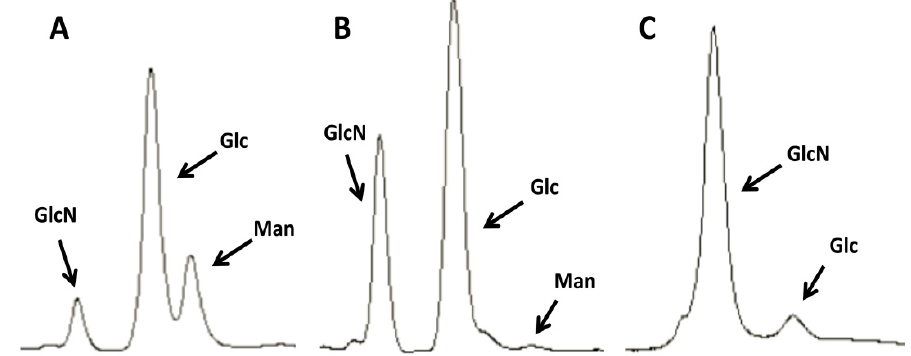
Figure 3. Purification of chitin from C. albicans yeast phase cells. Images representative of the HPLC profiles of C. albicans extracts at different stages of the chitin purification process. ( A ) Untreated cell walls; ( B ) after 3 KOH boils; ( C ) after an additional boil in a 1:1 mix of acetic acid and 40% H O . Man, mannose (mannans); Glc, glucose (glucans); 2 2 GlcN, glucosamine (chitin).